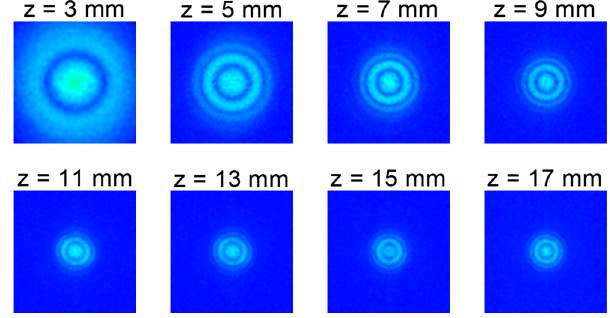
FIG. 15. Raw power spectra of broadband synchrotron radia- tion. Perfect azymuthal symmetry is a clear signature of pre- dominant temporal coherence, as discussed in Sec. II B.